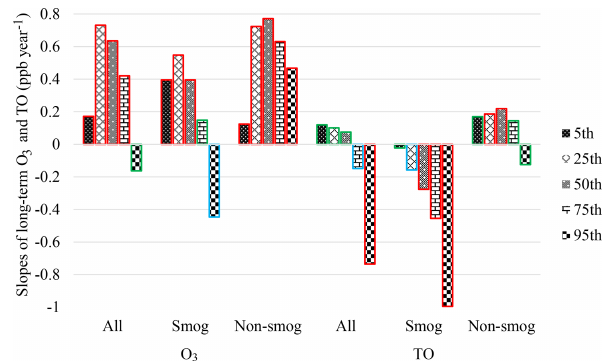
Figure 5. Slopes of long-term O 3 and TO trends at various per- centile levels in all months, smog season, and non-smog season in Windsor during 1996–2015 (red border: significant at p < 0 . 05; blue border: significant at p < 0 . 1; green border: not significant, i.e. p > 0 .